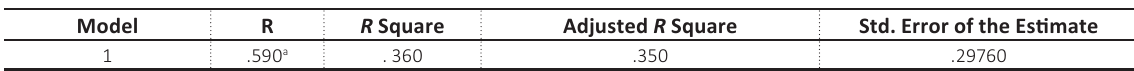
Table 3. Model summary b